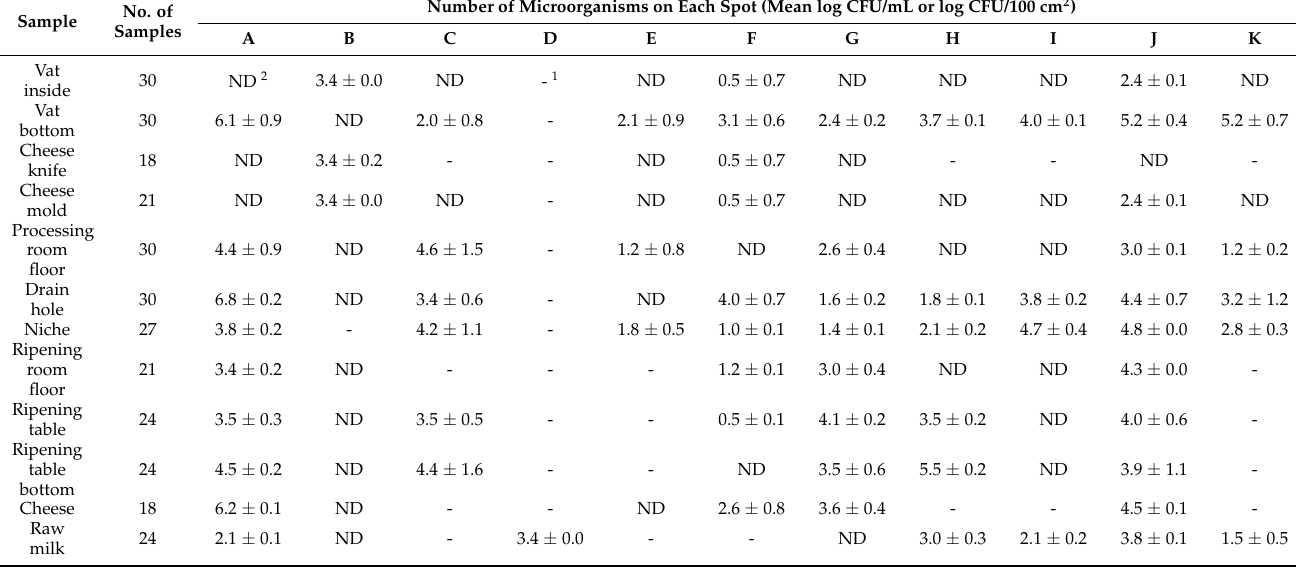
Table 7. Mean ( ± SD) yeast/mold counts in the processing plants of each dairy farm (A to K).